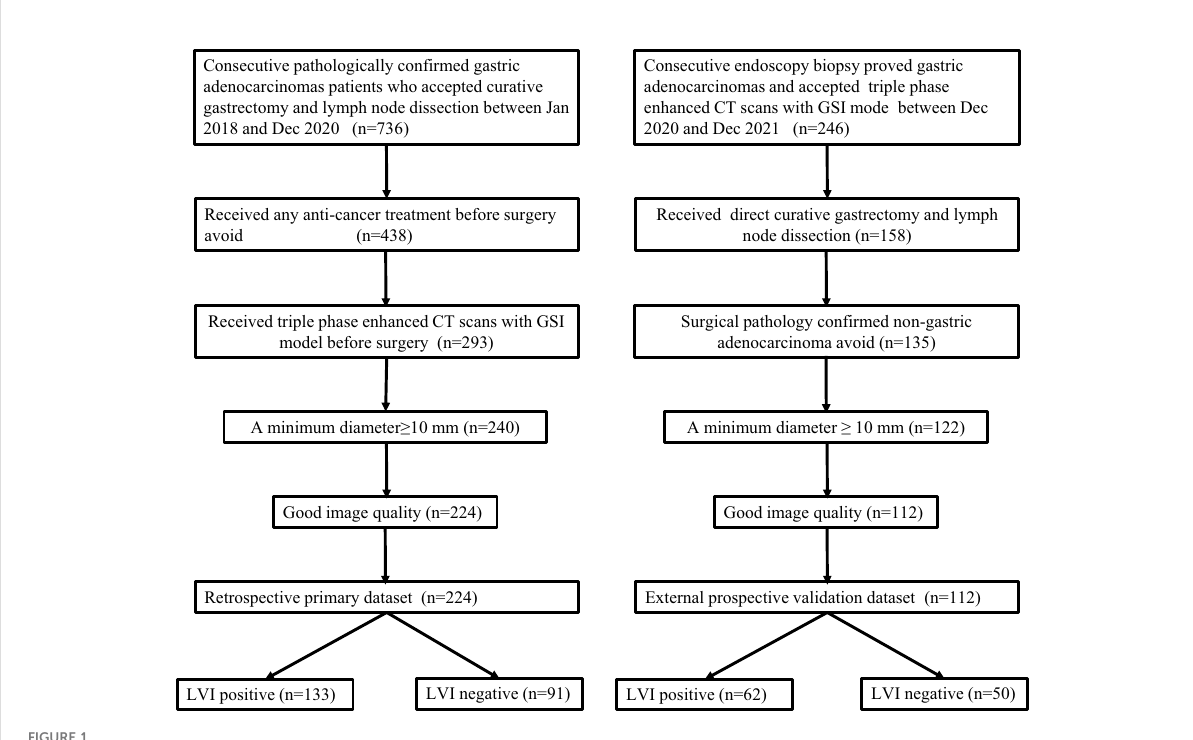
FIGURE 1 Flowchart of patient ’ s enrollment in the primary and validation